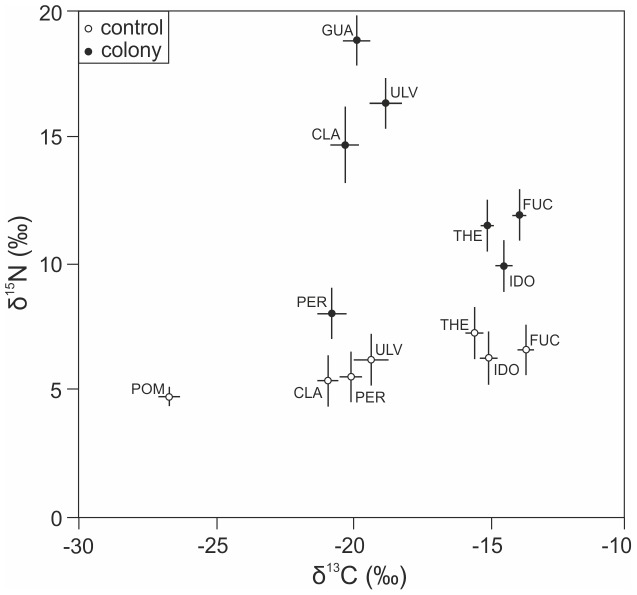
Stable isotope signatures (mean±SE) of all samples from colony (black circles) and control sites (white circles).POM  =  particulate organic matter (control sites only), GUA  =  guano (colony sites only), FUC =  Fucus vesiculosus, CLA =  Cladophora glomerata, ULV =  Ulva spp., PER =  periphyton, IDO =  Idotea balthica, THE =  Theodoxus fluviatilis.